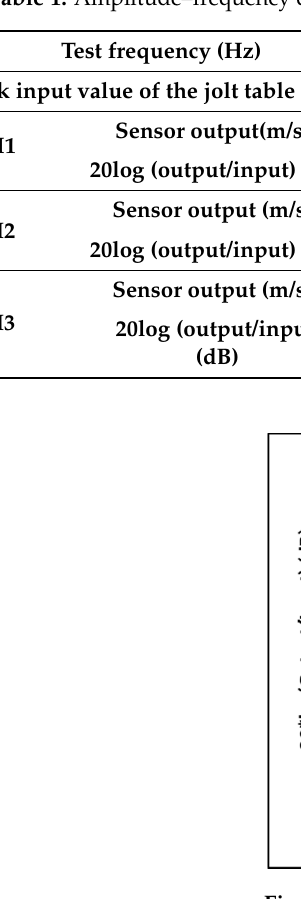
Figure 11. Input and output linear linearity for the data recorded on our instrument when placed on a jolt table. 4.3. Performance Indicators The main performance indicators of the developed seismic sensor are shown in Table 2, demonstrating that the sensor can meet the network access standard of the China Earthquake Administration’s high-precision seismic intensity meter (Table 2) [54]. Table 2. Correlation average seismic sensor development index and China Earthquake Administration’s high-precision seismic intensity calculation standard. Technical Indicators or Functional Indicators